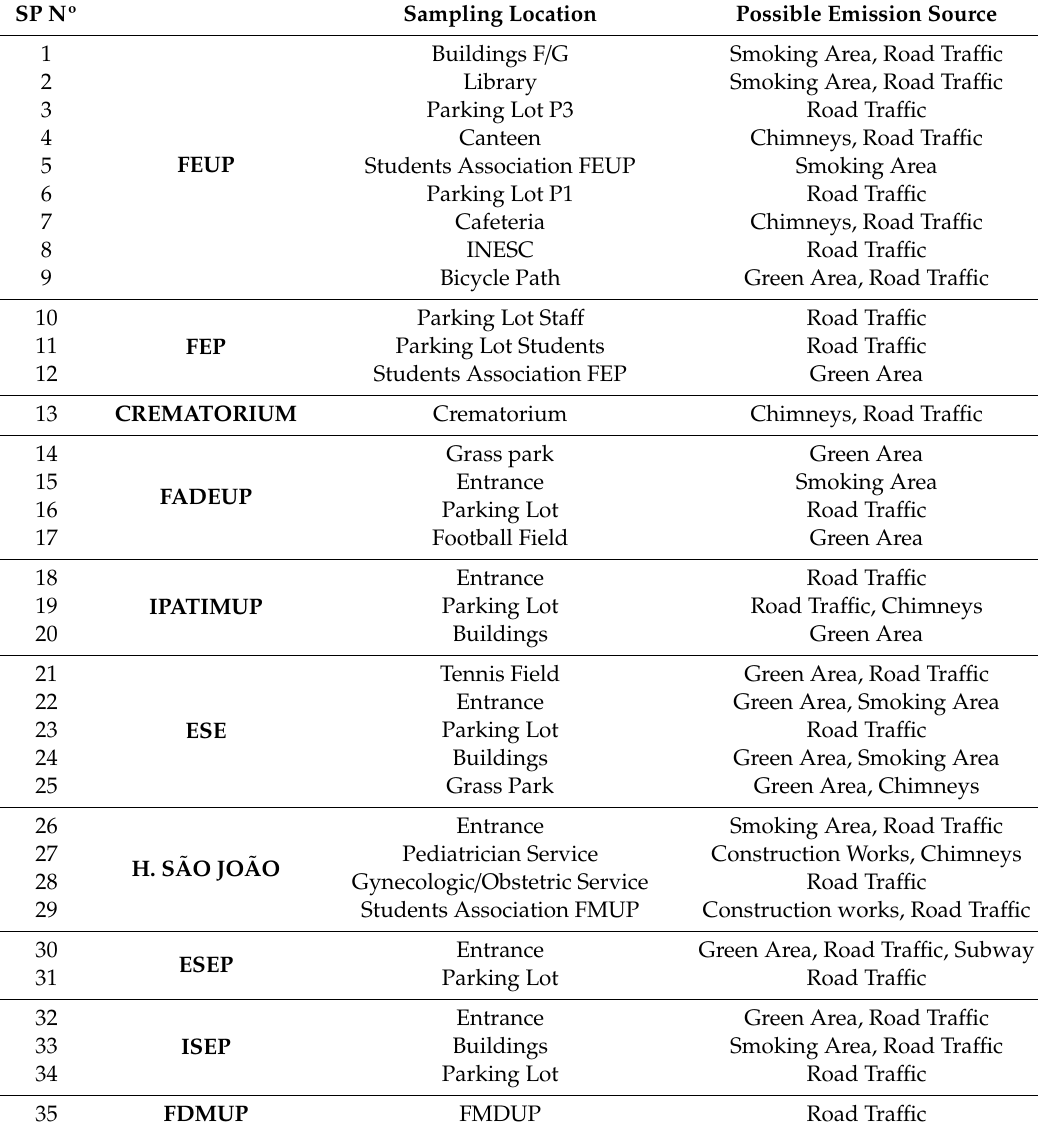
Table 1. Identification of the sampling points (SP) and the influence of possible emission